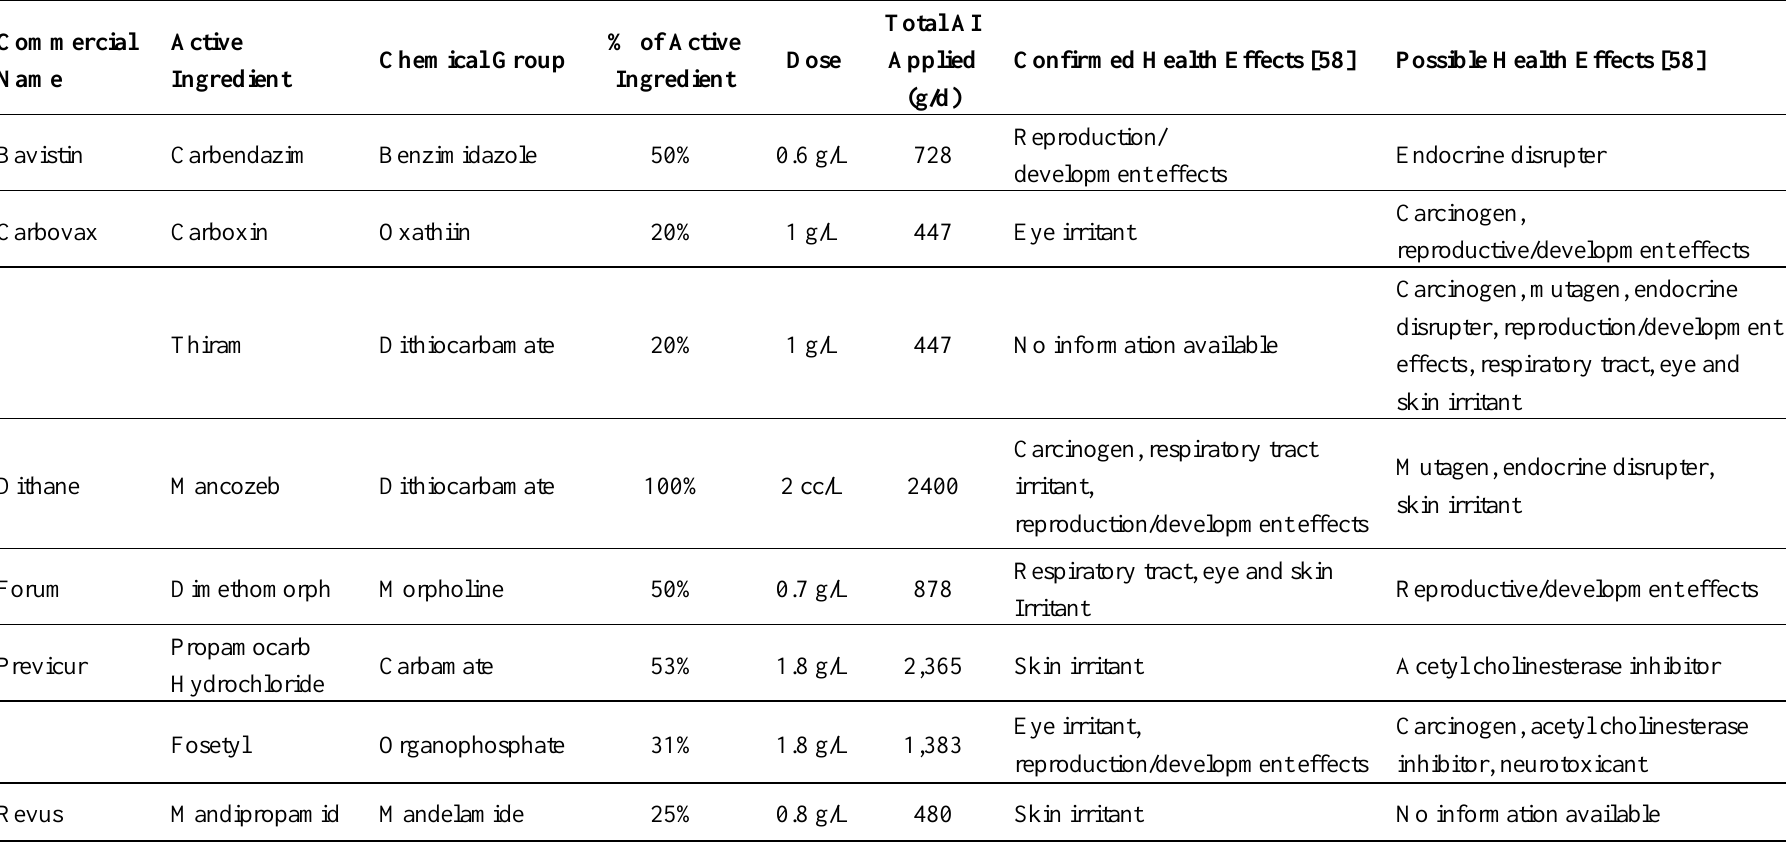
Table 1. Characteristics of the fungicides used in the case study during the study